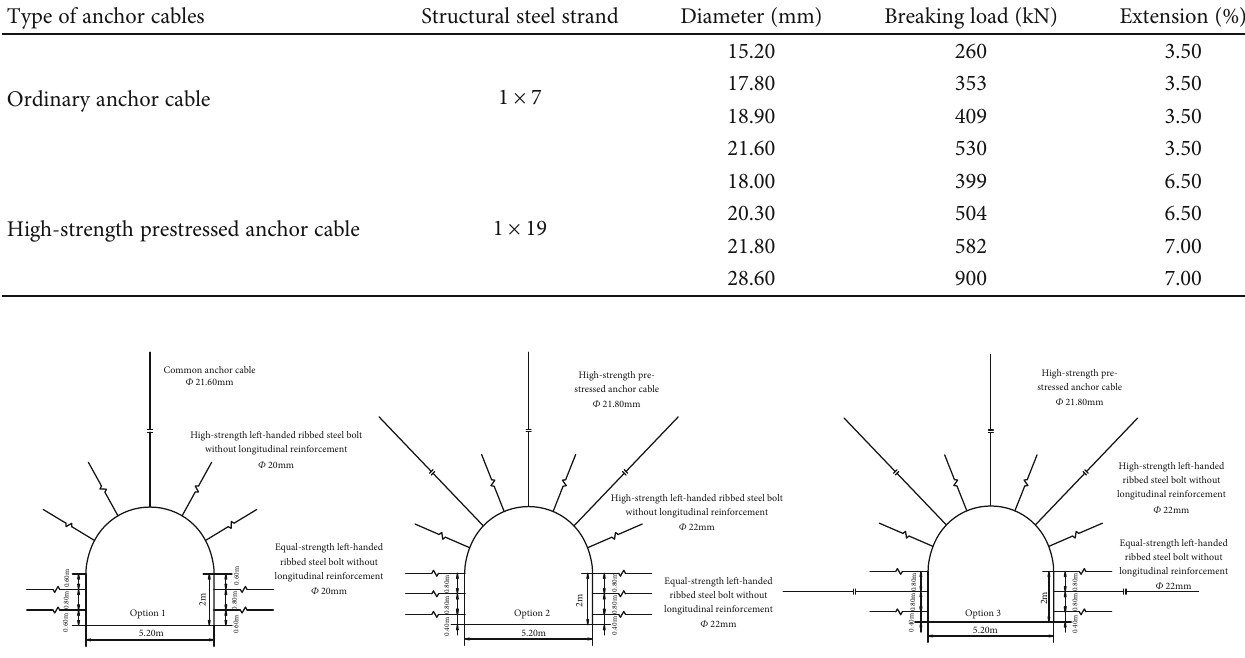
Figure 3: Schematic diagram of di ff erent support methods [27, 28].